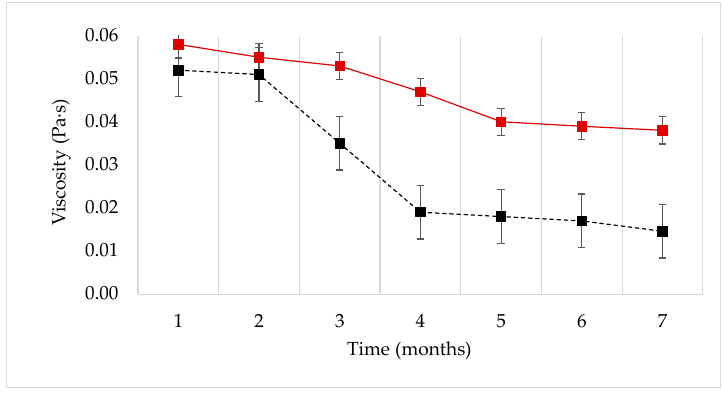
Figure 5. Viscosity as a function of time at a shear rate of 7.3 s − 1 . Storage and measurement at 𝑇 = 60 °C . Nanofluid (1000 ppm XG, 300 ppm NP-SiO 2 and 3% NaCl) (– ■ ). Polymer solution (1000 ppm XG and 3% NaCl) (- - ■ ) [18].